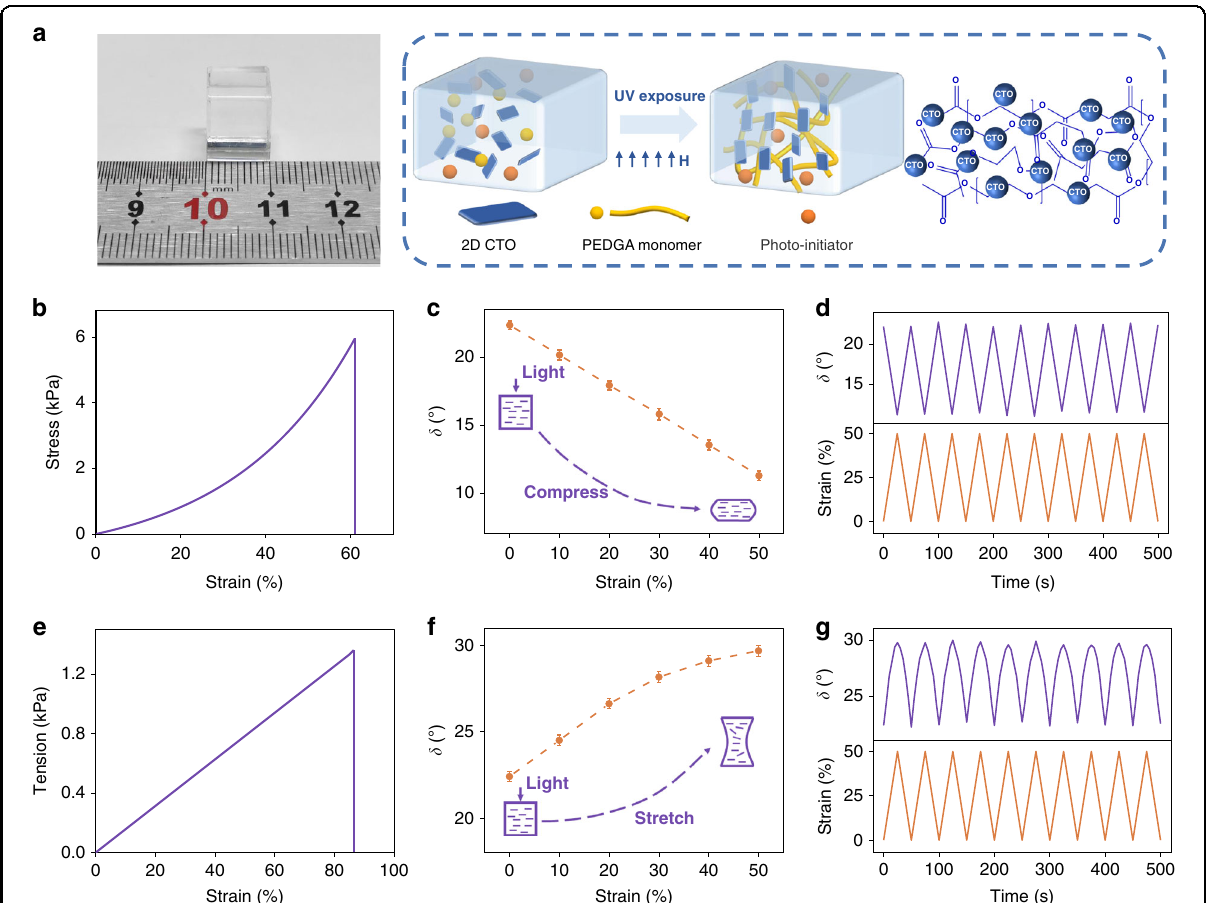
Fig. 3 Mechano-optical devices based on 2D CTO DUV hydrogel. a A photo of the CTO hydrogel (left) and scheme (right) of its fabrication process. b Compressive stress – strain curves of the CTO hydrogel. c Phase retardation induced by the uniaxial compression of hydrogel in the direction of light propagation. d Cycling test for the reversibility and stability of DUV modulation during compression. e – g Similar to b – d , but presenting the process of stretching. DUV light intensity: 200 mW cm −